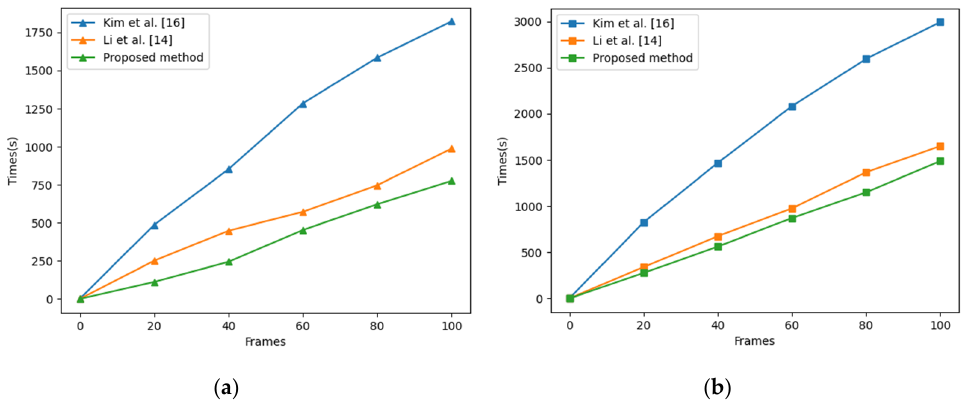
Figure 13. Runtime comparison of comparable methods on two videos. ( a ) The test object is the synthetic snow video (Figure 4). ( b ) The test object is the real rain video (Figure